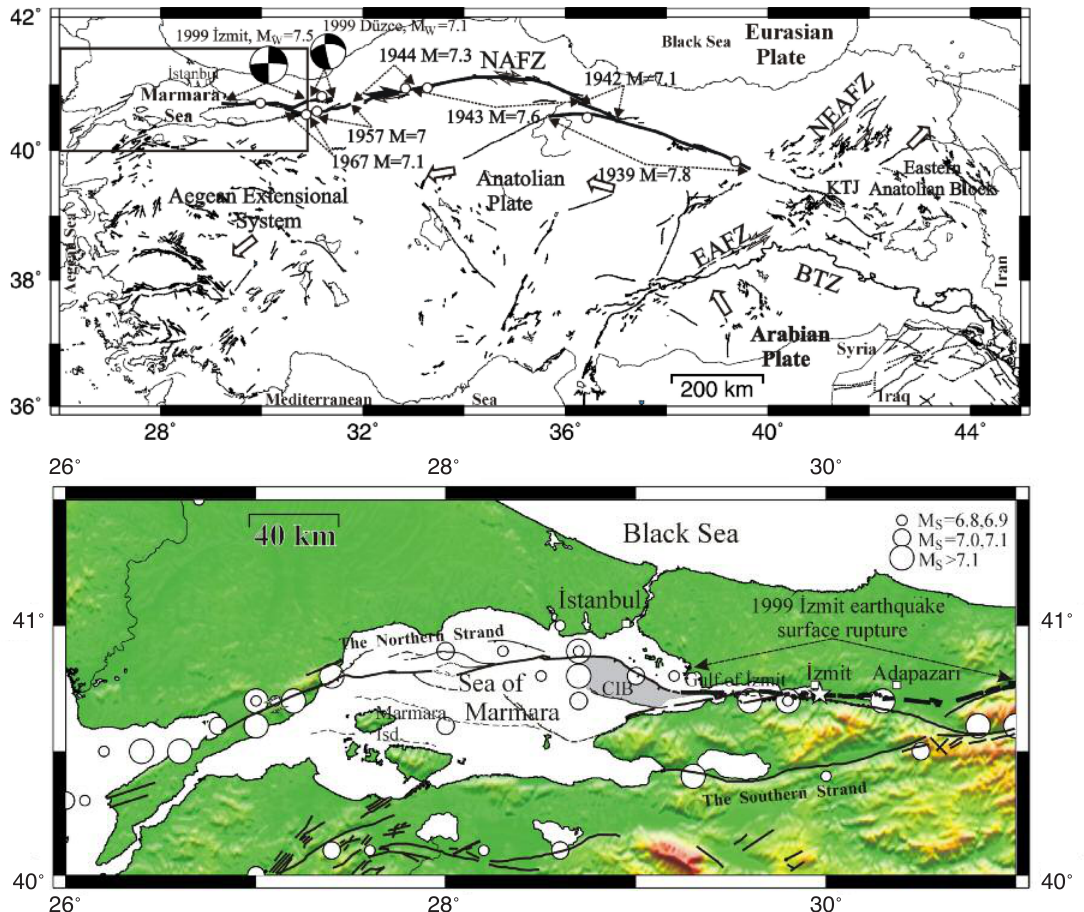
Figure 1 (top). Map showing the major tectonic settings of Turkey and the westward space-time migration of the large earthquake ruptures along the North Anatolian Fault Zone (NAFZ) between 1939 and 1999, as well as the focal mechanisms (black and white beach balls) of the August 17, 1999, İ zmit and November 12, 1999, Düzce earthquakes (compiled from Ş aro ğ lu et al. [1992], Barka et al. [2002], Tibi et al. [2001]). Open circles, earthquake epicentres; large arrows, plate motions relative to the stable Eurasian Plate; large rectangle, the map area shown in Figure 2. EAFZ, East Anatolian Fault Zone; NEAFZ, North-East Anatolian Fault Zone; KTJ, Karlıova Triple Junction; BTZ, Bitlis Thrust Zone. Figure 2 (bottom). Map showing the extent of the North Anatolian Fault Zone (NAFZ) in NW Turkey, along with the epicenters of M (white filled circles) after 400 AD [ Ş aro ğ lu et al. 1992, Ambraseys 2002]. The extent of the NAFZ beneath the Sea of Marmara is after Armijo et al. [2002]. The extent of the surficial ruptures of the August 17, 1999, İ zmit earthquake are also shown (thick black lines). Gray filled area, Çınarcık Basin (CIB). See Figure 3 for a larger scale map and for detailed information of the surficial ruptures.